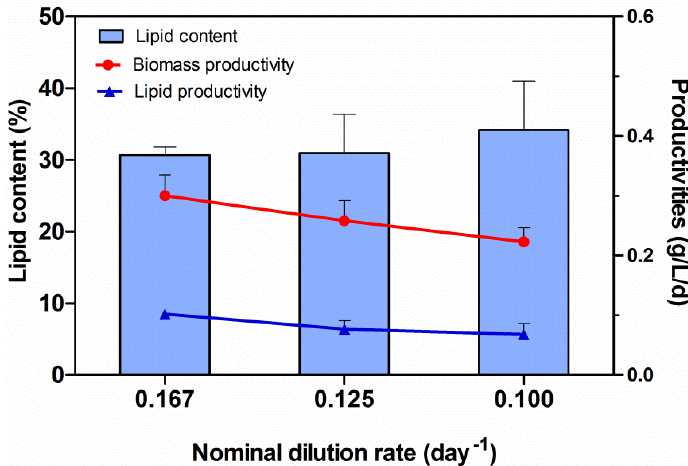
Figure 5. Lipid content in the dry-biomass of Chlorella and lipid and biomass productivities. Experiments were performed using a C PBR (working volume of 350 mL). G Chlorella vulgaris CCALA 896 was grown by using a modified Kolkwitz medium under three different repetitive batch-growth regimens, as reported in the previous Figure